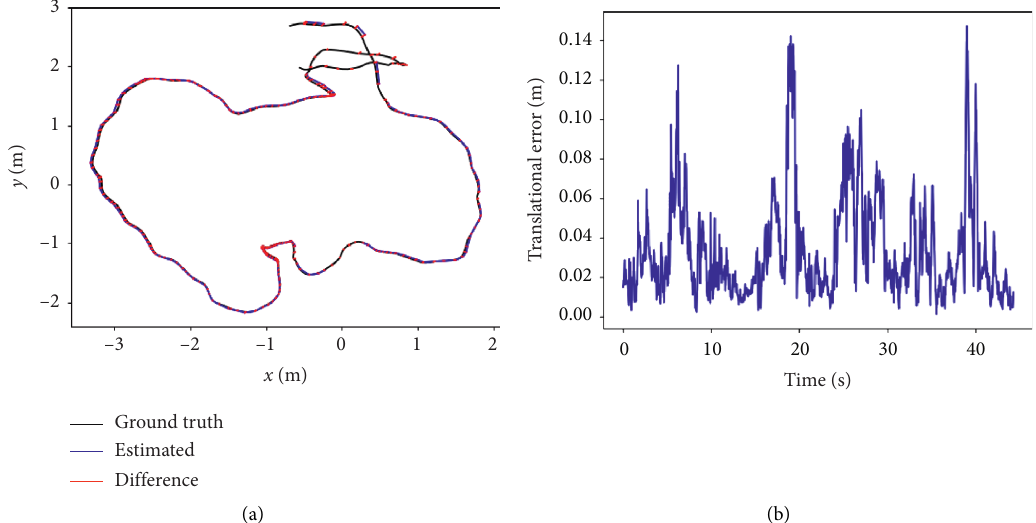
Figure 11: Error analysis of dataset freiburg2_large_with_loop. (a) Absolute track error for construction of map. (b) Relative pose error for construction of map.